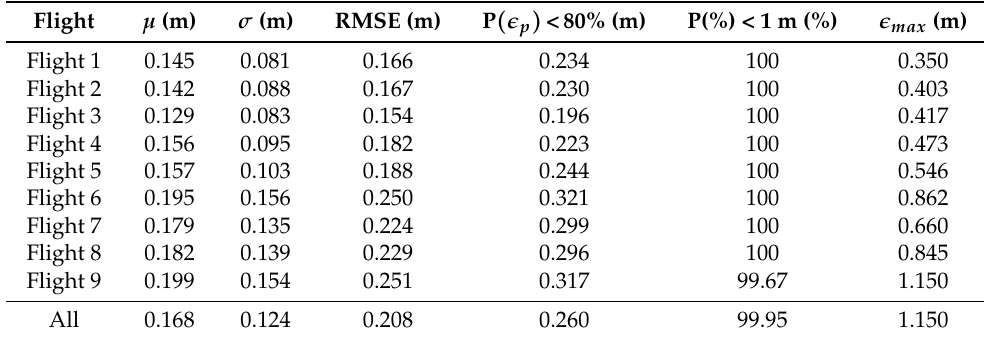
Table 8. Accuracy data when combining tags.